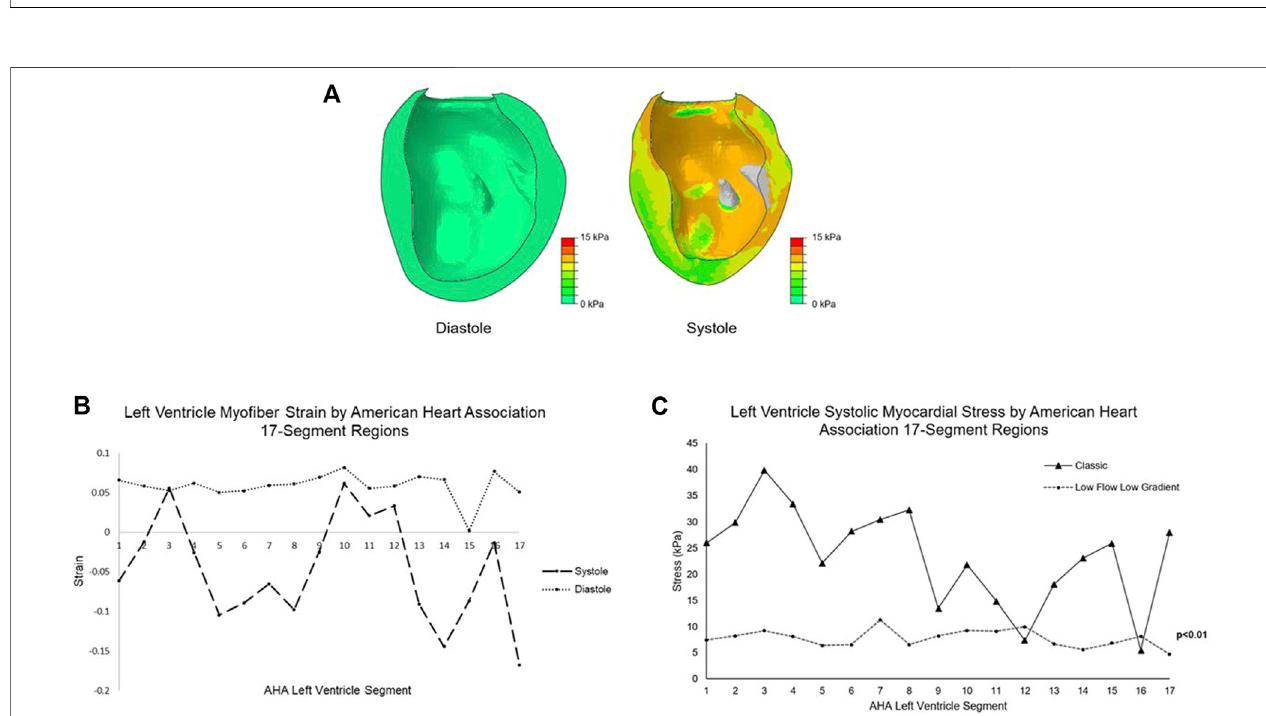
FIGURE 3 | (A) Color plots of the left ventricle myocardial stress (kPa) at end diastole and peak systole. The papillary muscles are excluded from biomechanical analysis. (B) Mean myo fi ber strain at diastole and systole for the LFLG model by American Heart Association 17-segment left ventricle classi fi cation system. (C) The meansystolicstressofeachleftventriclesegmentbyAmericanHeartAssociationclassi fi cationsystemfortheLFLGmodelcomparedtotheidealizedleftventriclemodel with classic severe AS. Lower magnitude stress values and low variation among the segments are found in the LFLG model. Segments 1-6 represent the basal aspect, segments 7 – 12 the LV mid-wall, and 13 – 17 the apical region. LFLG: low- fl ow, low-gradient; LV, left ventricle; AS, aortic stenosis.